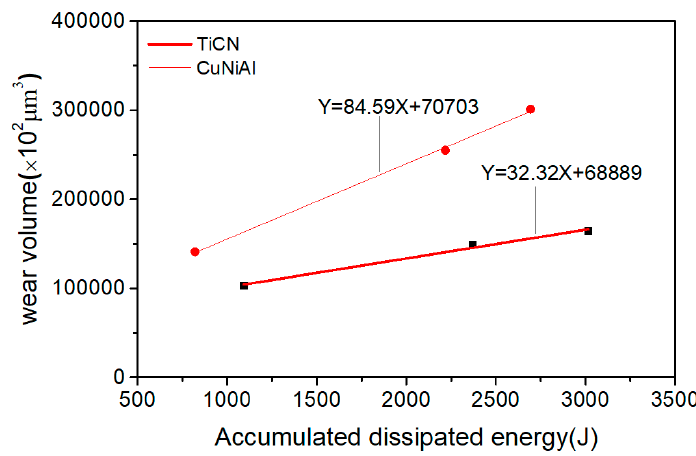
Figure 12. Wear volume vs. accumulated dissipated energy in artificial seawater.